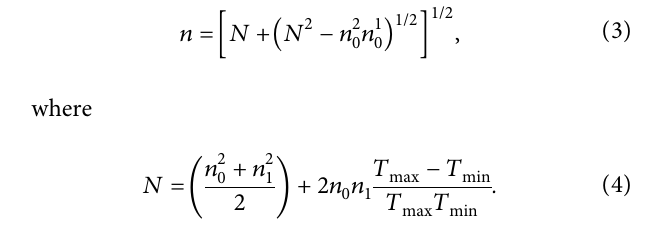
2 at various oxygen/argon gas